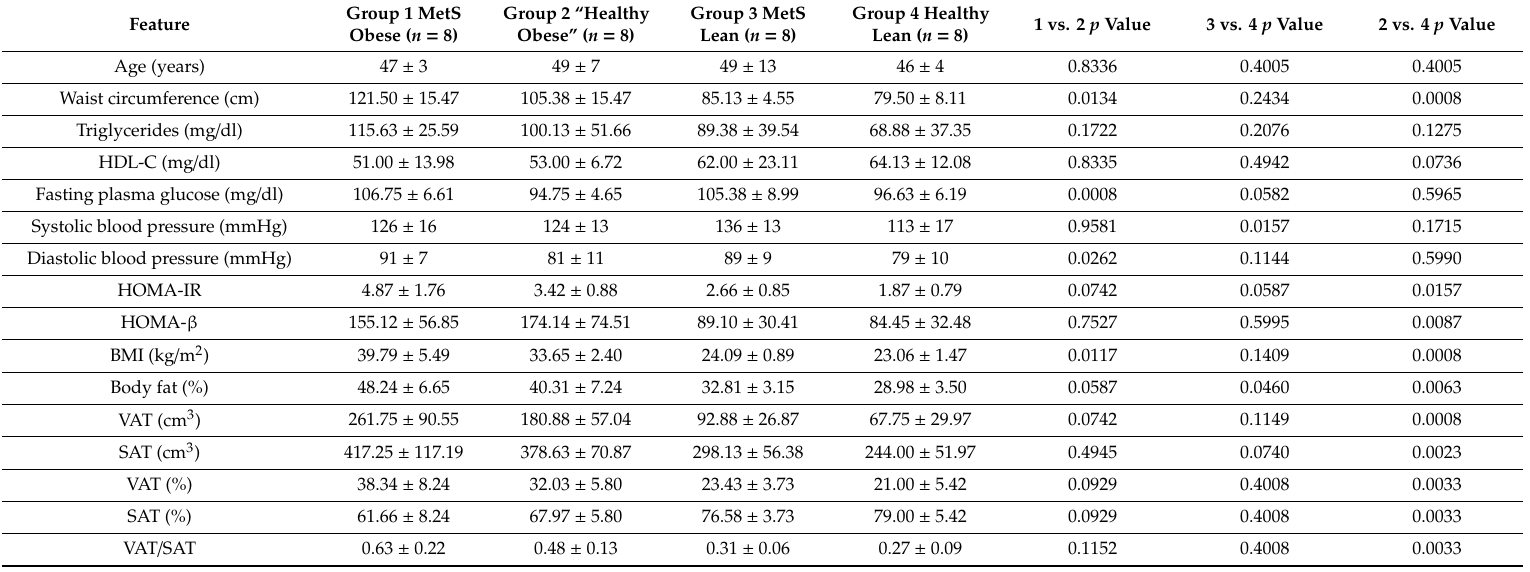
Table 1. Clinical characteristics of study